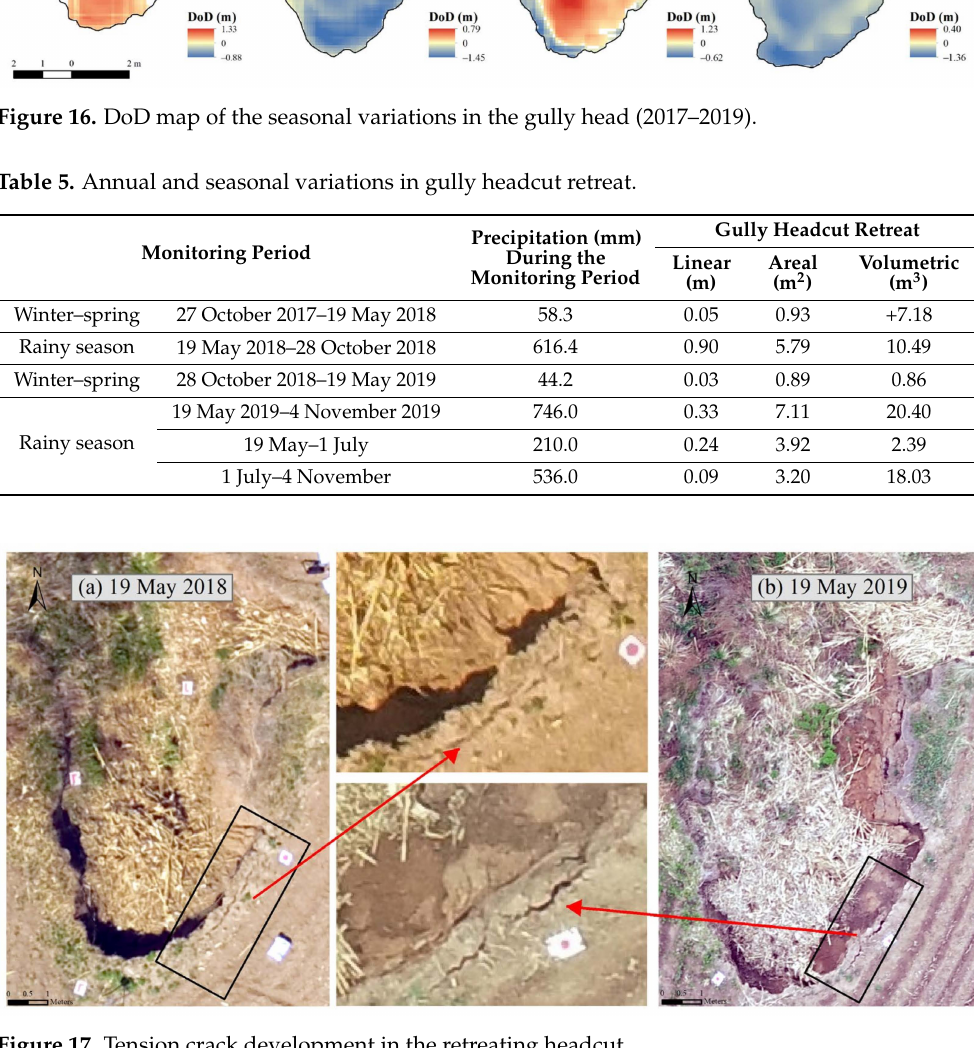
Figure 17. Tension crack development in the retreating